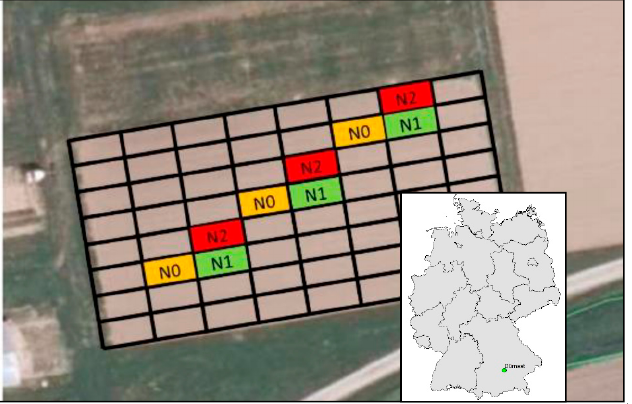
Figure 1. Location of experimental plots (4 × 8 m 2 ) fertilized with calcium ammonium nitrate across the long-term field experiment (N0 without fertilization, N1 moderately fertilized, N2 highly fertilized).